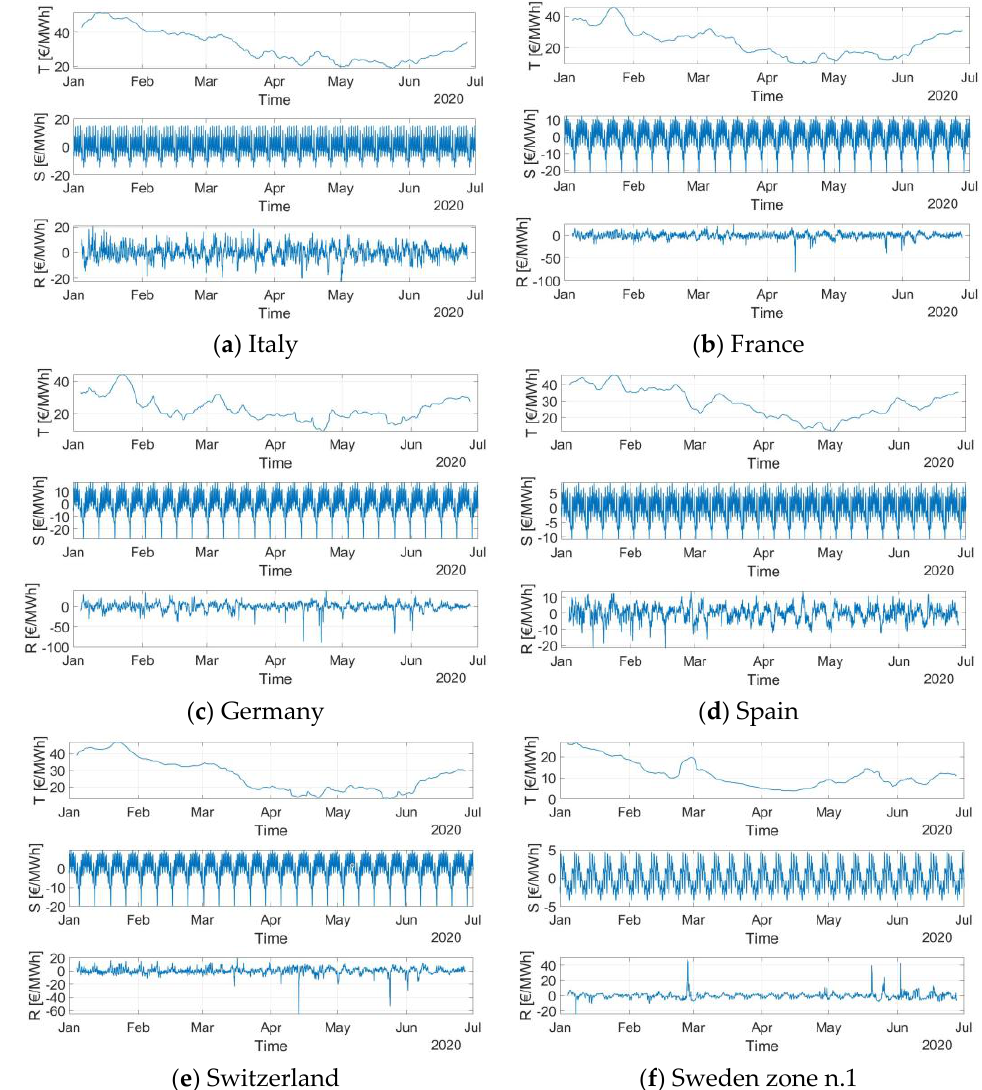
Figure 10. Decomposition of additive time series [€/MWh], first 27 weeks of 2020 (T = Trend, S = Seasonal, R = Random).